Question: Does the plotted quantity increase or decrease?
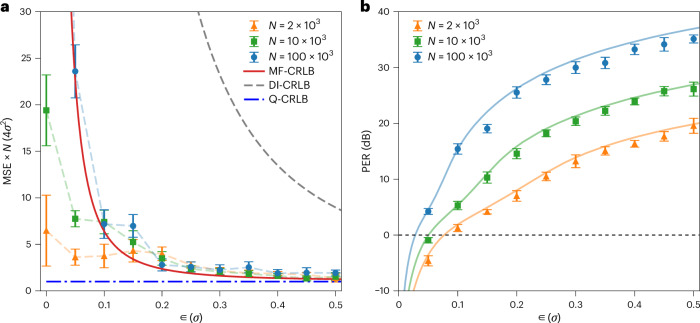
Answer: increasing